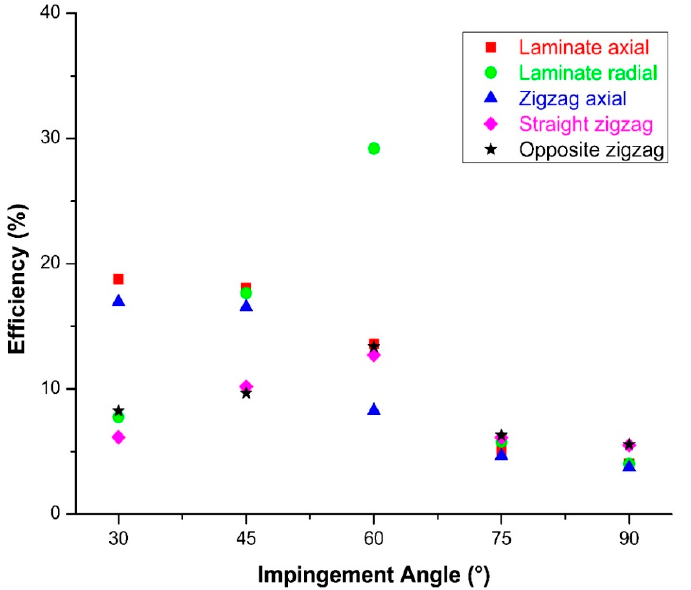
Figure 15. Effect of impingement angle on erosion efficiency in BFR/EP composite pipe outer surface radial and axial orientations.